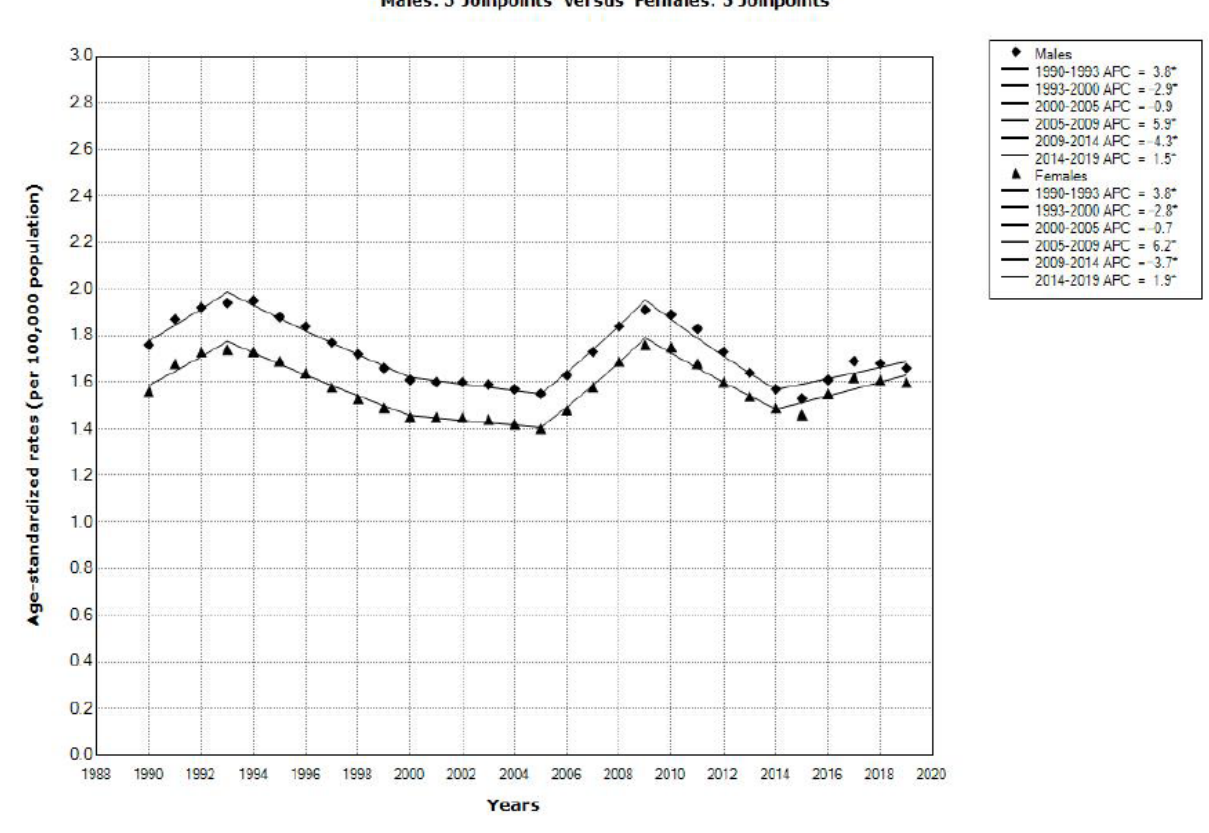
Figure 6. Joinpoint regression analysis of global cholera mortality, by sexes, 1990–2019. * Statistically significant trend ( p < 0.05). (Source of data Ref. [10]). In both males and females, trends for cholera-related mortality rates from 1990 to 2019 showed significantly decreasing trends in three regions: in the European Region (AAPC = −1 0.5% and AAPC = −1 0.6%, respectively), the Western Pacific Region (AAPC = −8 .2% and AAPC = −8 .3%, respectively) and the South-East Asia Region (AAPC = −7 .4% and AAPC = −7 .3%, respectively) (Figure 7). In the African Region, significantly increasing cholera-related mortality trends were observed both in males and females (AAPC = 1.3% and AAPC = 1.1%, respectively). In the Eastern Mediterranean Region, stable trends for cholera mortality rates were observed both in males and females (equally, AAPC = −0 .3%). Joinpoint results are not shown for mortality in the Region of the Americas because no case of cholera death occurred in at least one year in the observed period.